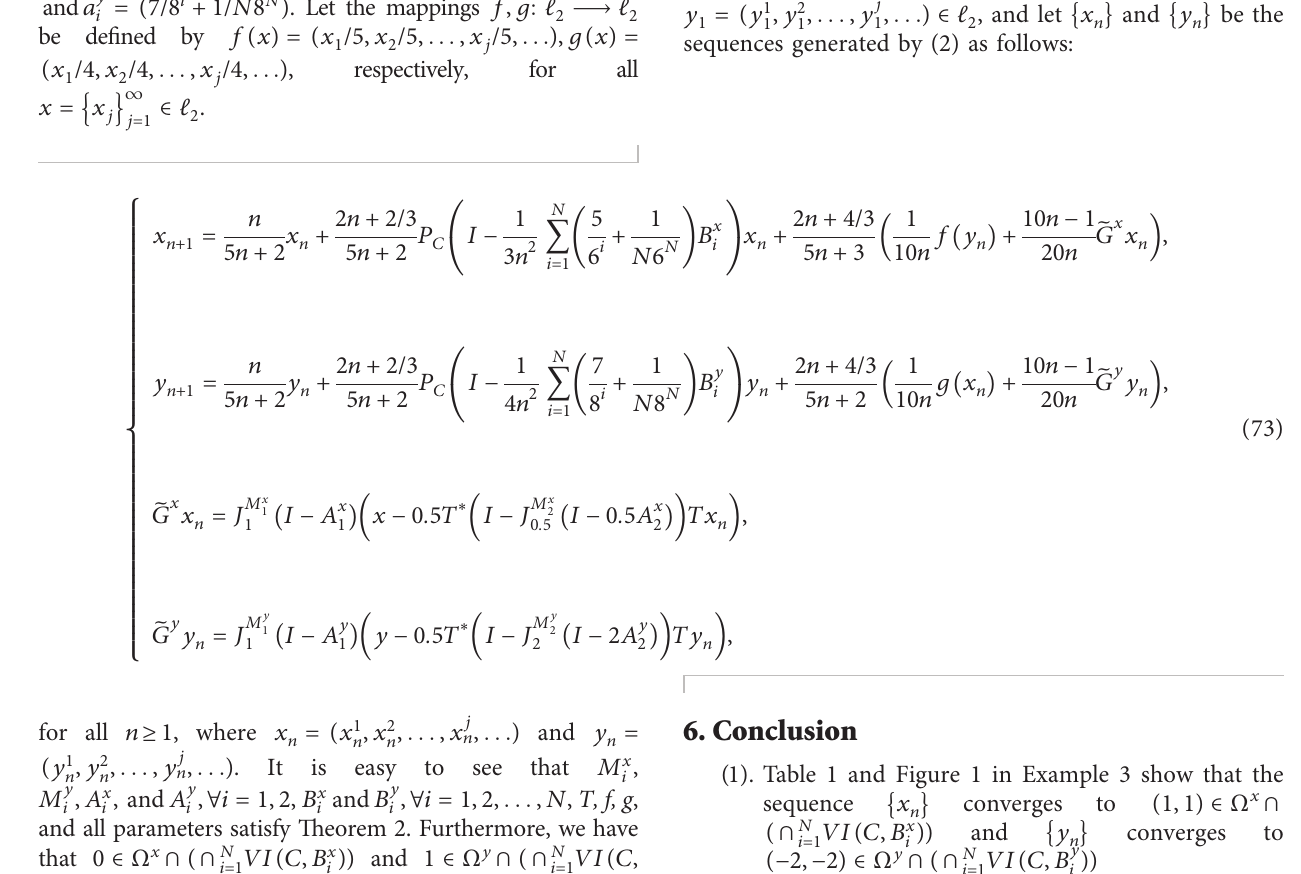
􏼈 􏼉 and y 􏼈 􏼉 with initial values x n n